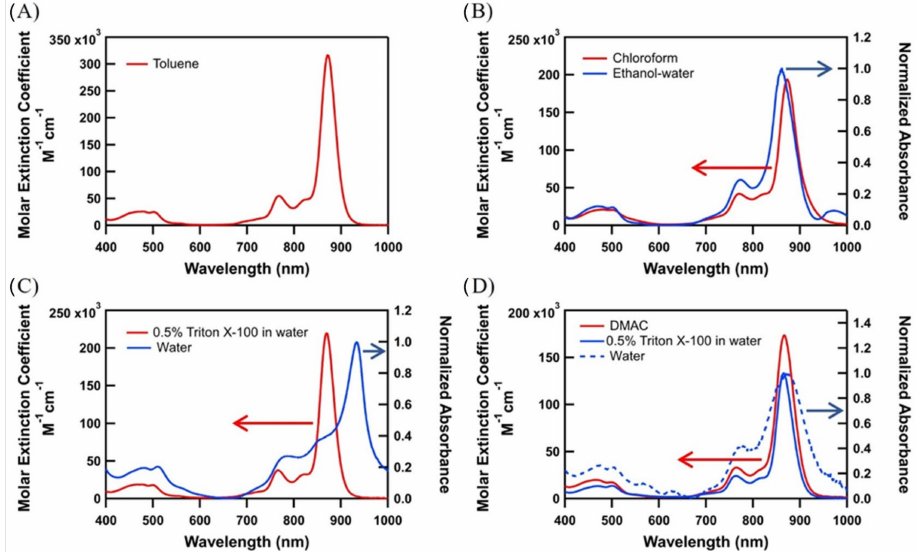
Figure 2. UV − Vis absorption spectra of Silicon-centered naphthalocyanine dyes. ( A ) SiNC-1, ( B ) SiNC-2, ( C ) SiNC-3 and ( D ) SiNC-4, in selected solvent systems. Red curves are molar ex- tinction coefficients, plotted on the left axis. Blue curves are normalized absorbance data in the denoted solvent, plotted on the right axis. Blue dotted curve in D is the normalized absorbance data in water. DMAC: